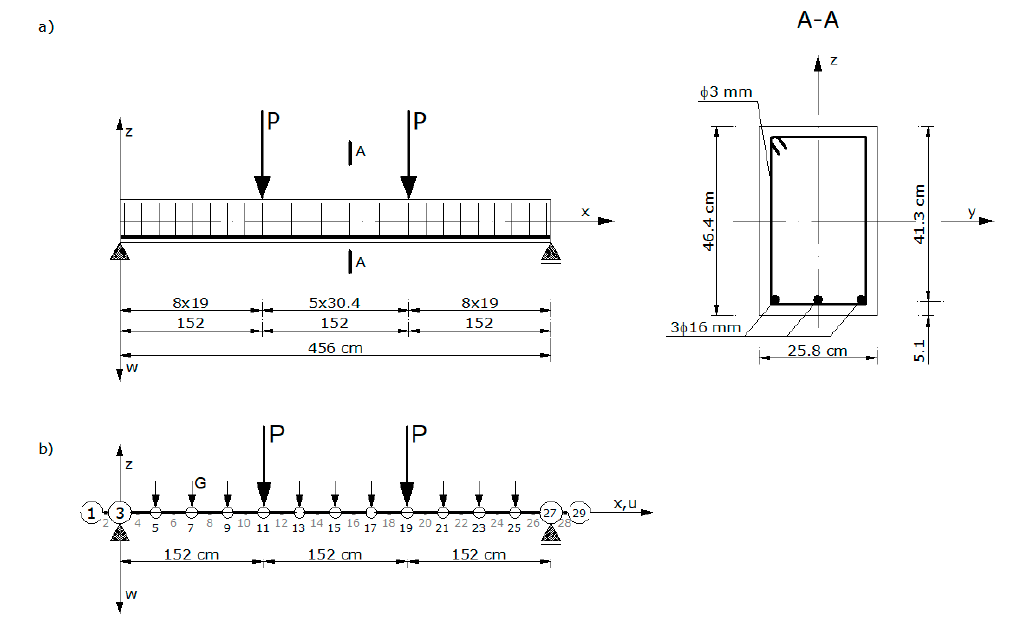
Figure 8. Buckhouse’s C1 beam: ( a ) static scheme, ( b ) computational model.